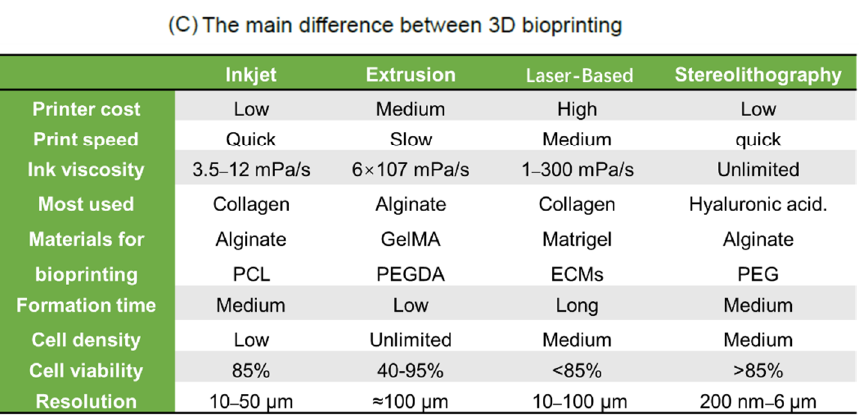
Figure 1. Schematic diagram of bioprinting technology and comparison of bioprinter types. ( A ) bioink preparation for 3D bioprinting; ( B ) schematic representation of the 3D bioprinting technologies—inkjet bioprinting, extrusion-based bioprinting, laser-assisted bioprinting and stereolithography-based 3D bioprinting; ( C ) difference between the types of 3D bioprinting. Reproduced, with permission, from